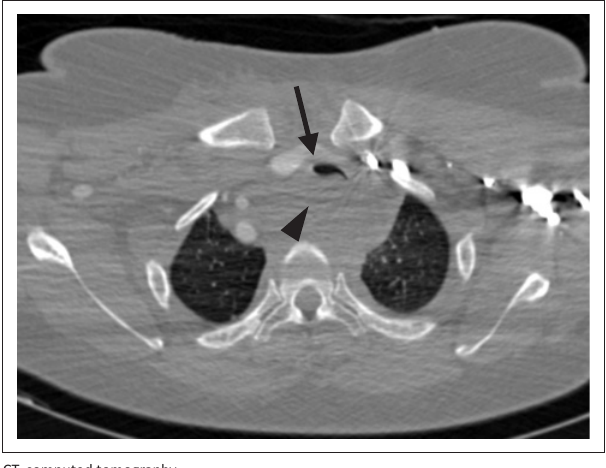
CT, computed tomography. FIGURE 7: Axial CT shows severe tracheal narrowing (arrow) due to mediastinal haematoma